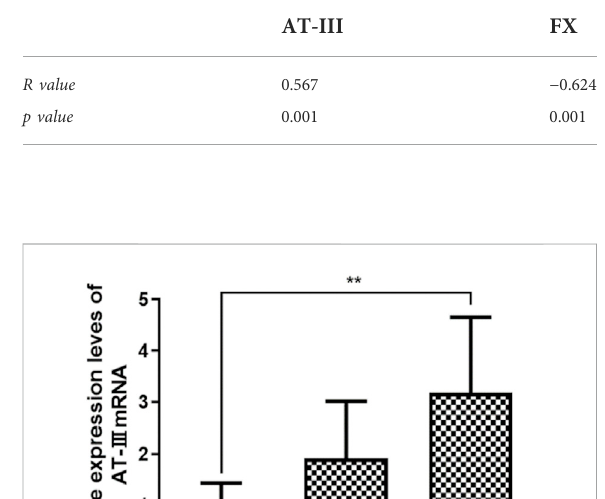
TABLE 5 Correlation of AT-III and FX with heparin sensitivity.